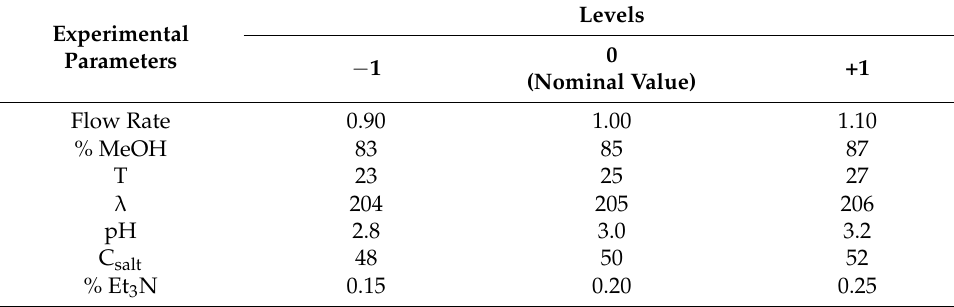
Table 1. Experimental factors and their examined levels.